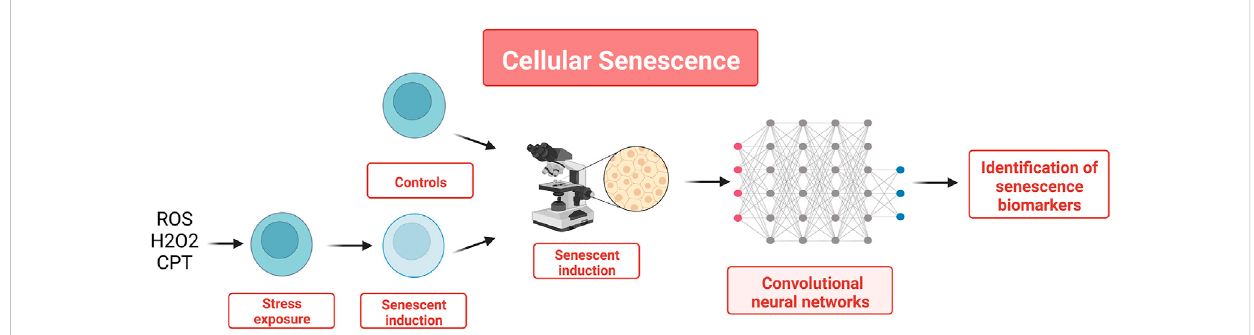
FIGURE 4 To identify novel aging-related proteins, the full set of human proteins was extracted from the Swiss-Prot database. Already known aging related proteinslistedontheGenAgedatabasewereusedasinstancesoftheaging-relatedclass.UniProt,GeneOntologyandGeneFriendsdatabaseswereused toextract21,000proteincharacteristicsthatweresubsequentlyusedasfeaturestotrain3classi fi